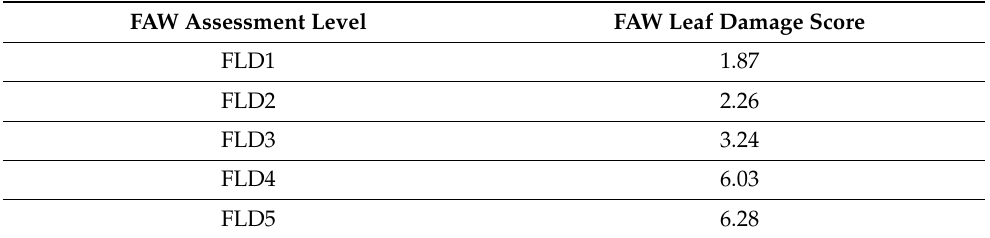
Table 10. FAW damage ratings based on AUPPCs for all maize genotypes from FLD1 to